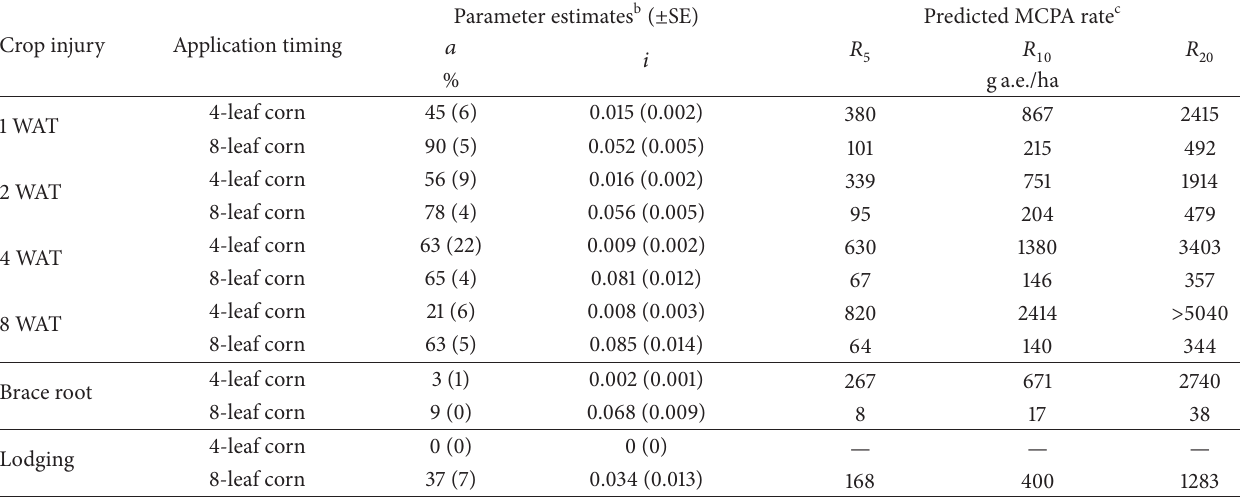
Table 1: Parameter estimates and predicted MCPA rates from regression models of visible percent field maize injury 1, 2, 4, and 8 WAT, brace root injury 8 WAT, and percent lodging prior to harvest a